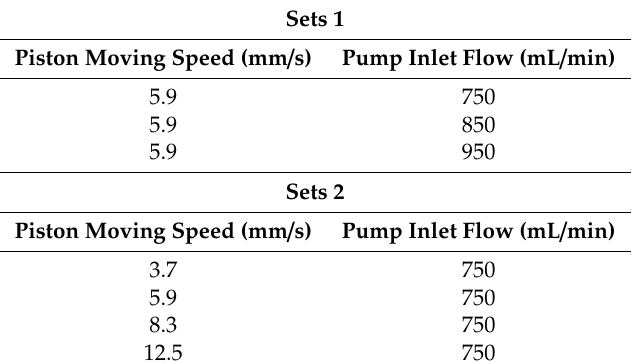
Table 2. The inlet boundary